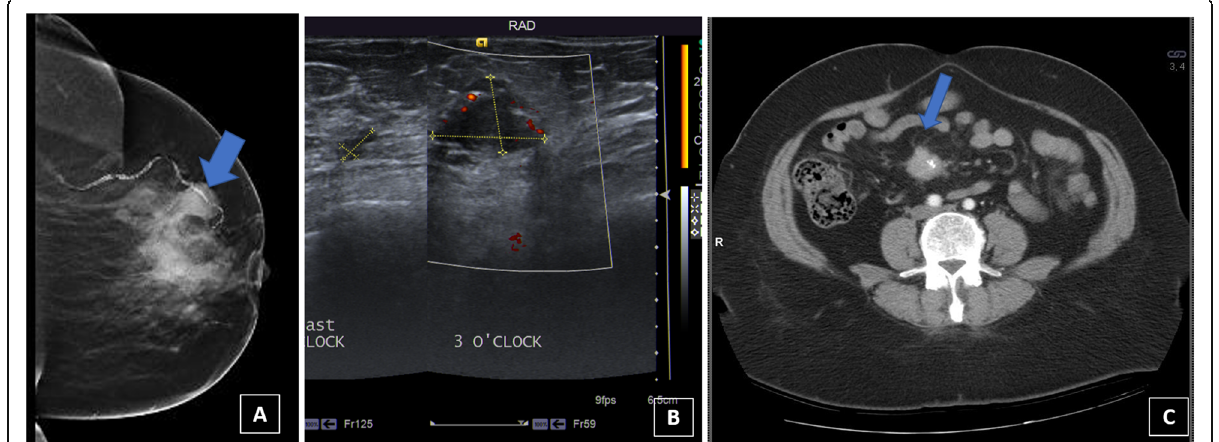
Fig. 1 Case one: 72-year-old female with left breast lump. A Left breast CC Tomo view showing a well circumscribed mass at 3 o ’ clock position (arrow). B HHUS with Doppler showing internal vascularity with an anterior advancing edge. ABUS showed a circumscribed hypoechoic mass (not shown). Core biopsy revealed neuroendocrinal carcinoma metastasis. C Axial CT slice of the lower abdomen showing the primary mesenteric carcinoid with central calcification and marginal speculation (arrow)